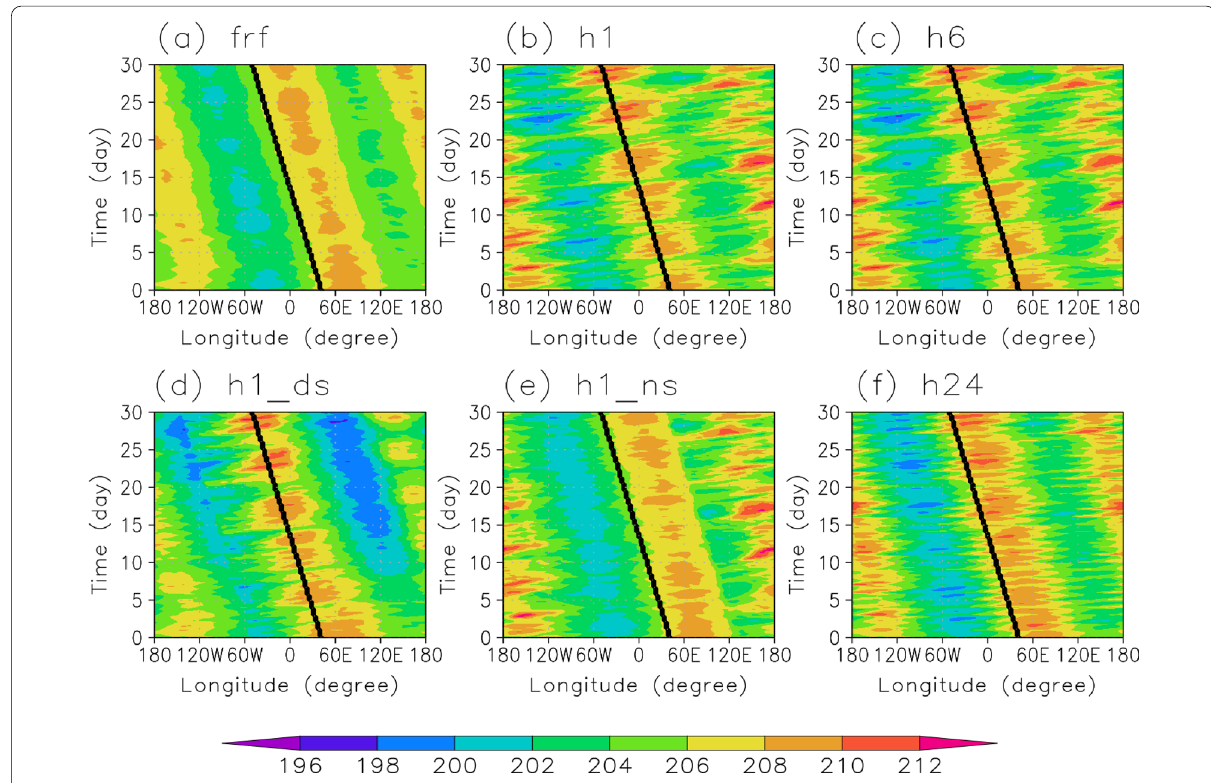
Fig. 1 Longitude–time cross sections of temperature (K) deviations at 70 km altitude and the equator. a Free run forecast (frf) of AFES-Venus (without data assimilation), hourly observations on b global (h1), d dayside (h1_ds), e nightside (h1_ns), and c 6-hourly (h6) and f 24-hourly (h24) observations on global are shown, respectively. The black lines indicate the sub-solar